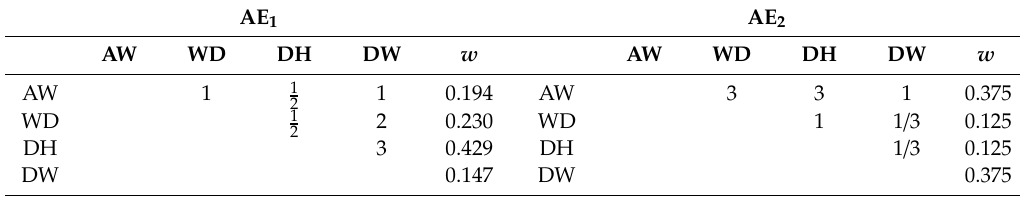
Table 3. Individual judgment matrices (AE 1 –AE 3 ) with priority vectors, and consensus matrix with group priority vector.